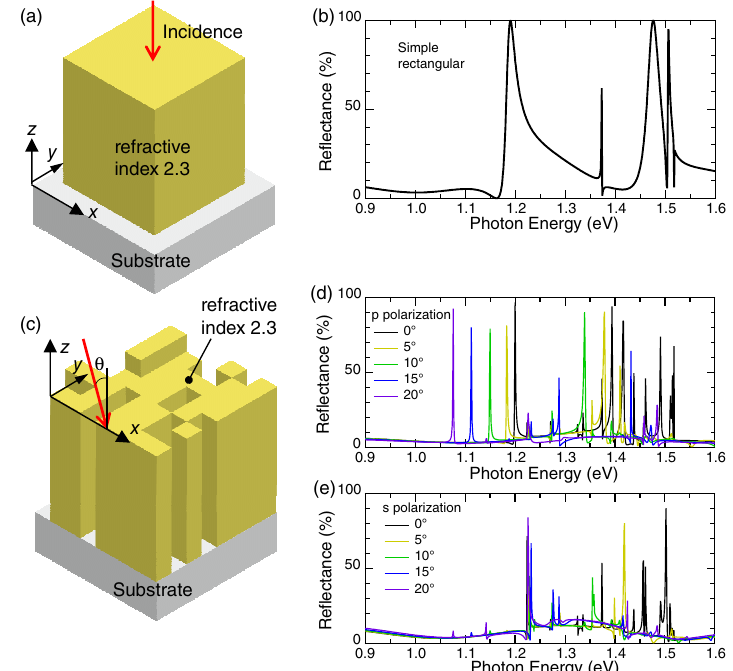
Figure 3. ( a , b ) A unit cell of a simple square-lattice metasurface of nano-rods and the R spectrum at the normal incidence, respectively; the periodic length is 560 nm; the side of the material with a refractive index of 2.3 (yellow) is 420 nm; and the height is 680 nm; ( c – e ) a high-performance 2D unit cell found in the non-empirical search; ( c ) the unit cell and incident configuration are depicted in a 3D manner; the period length is 560 nm, and the height of the unit cell is 680 mn; ( d , e ) linearly polarized R spectra at p and s polarizations are shown,